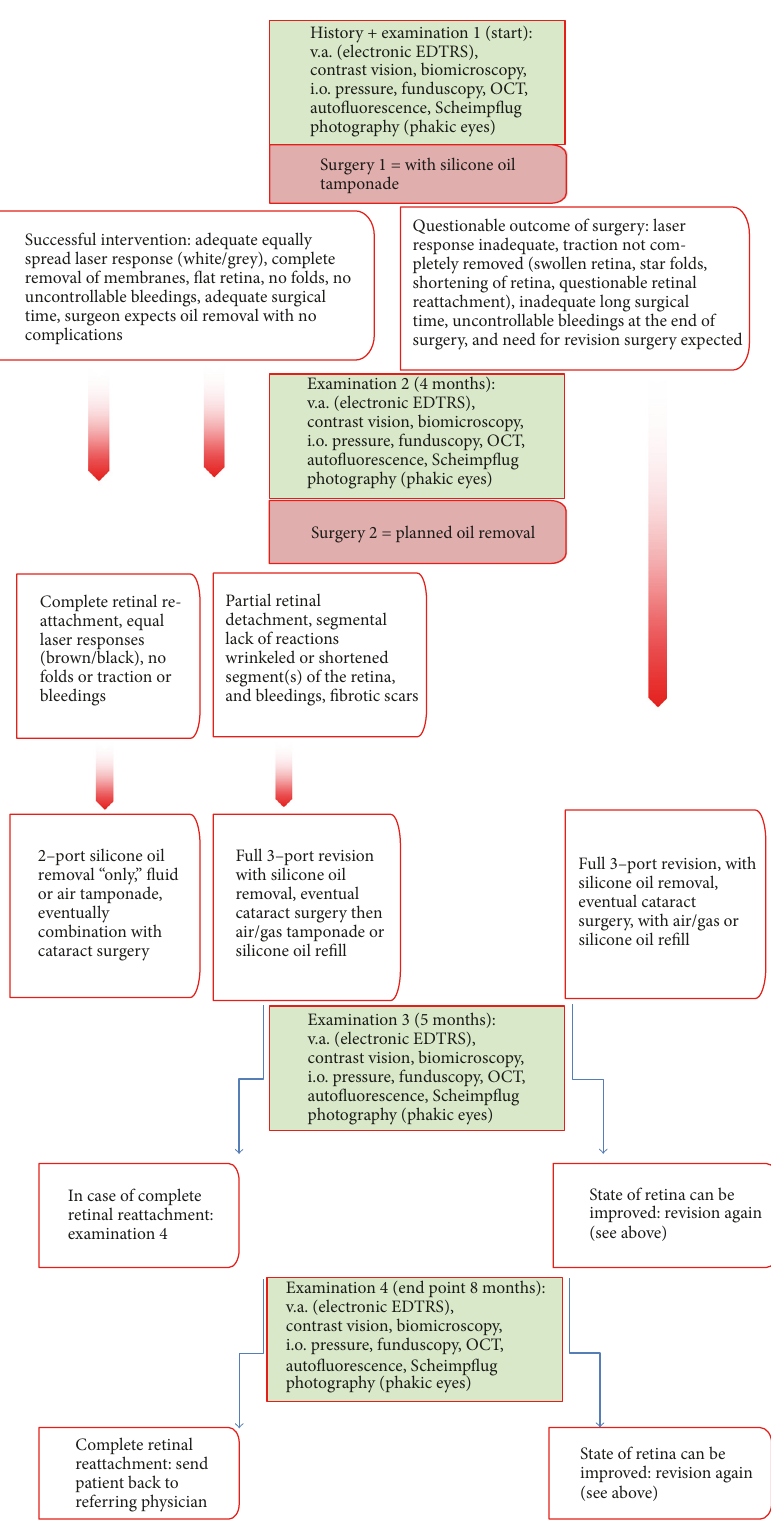
Figure 2: Standard operation procedure for the surgery of complex retinal detachments with preliminary silicone oil tamponade (initial version). EDTRS = international standard to present visual acuity (v.a.) values; biomicroscopy = examination of the anterior segment of the eye, for example, the lens; i.o. pressure = measurement of the pressure in the eye; funduscopy = examination of the retina; OCT: optical coherence tomography = noninvasive “ cutting through ” the retina using light wavelengths; auto fl uorescence; special photography of the retina RPE complex; Scheimp fl ug photography; special measurement of lens changes, related, for example, to aging, diabetes mellitus, in fl ammation, and